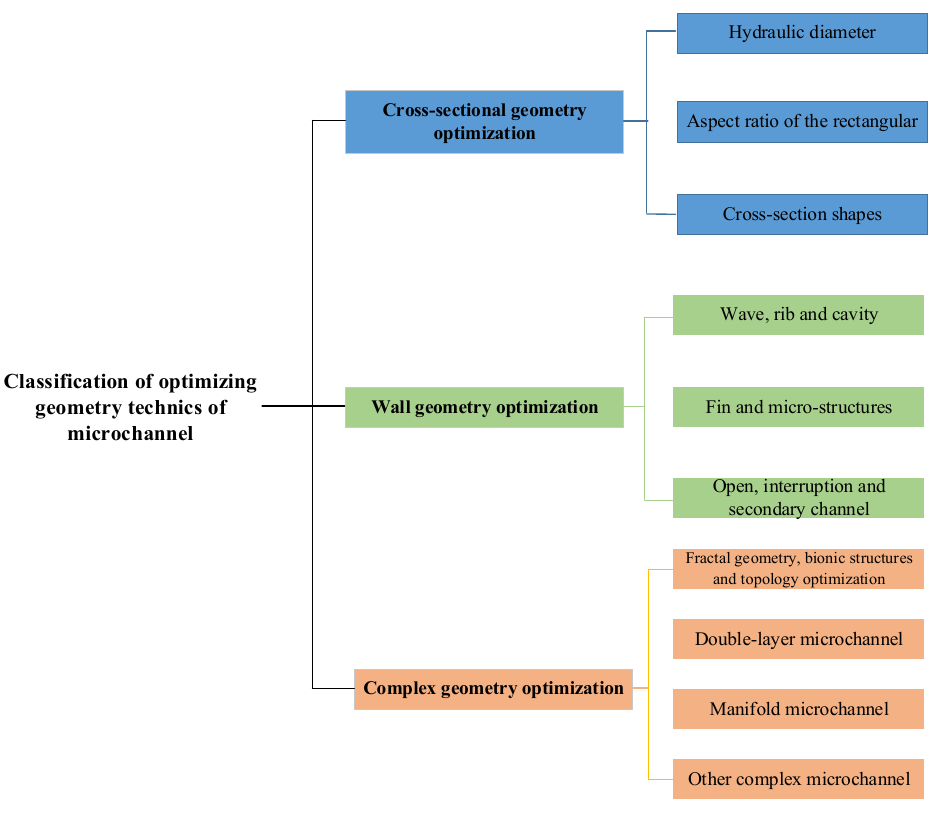
Figure 1. Classification of optimizing geometry technology of microchannel.